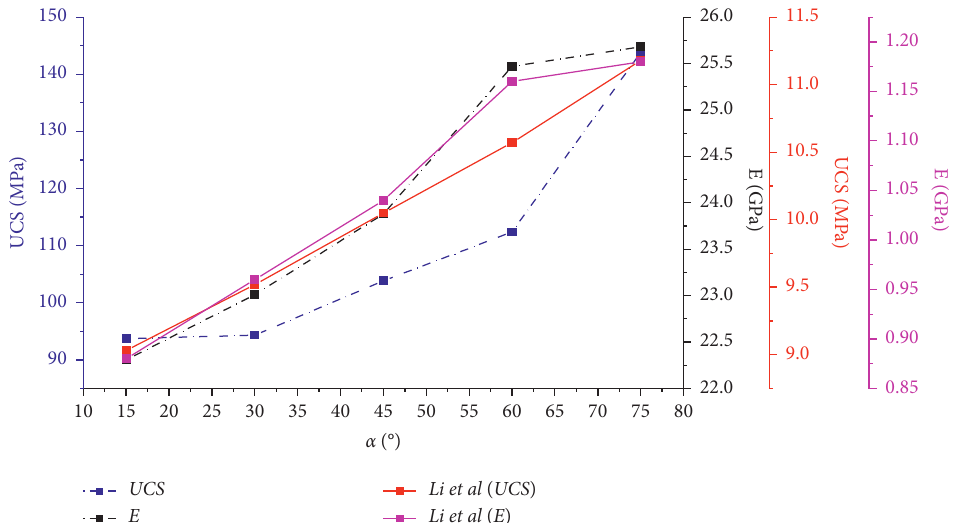
Figure 6: Cracked concrete peak strength and elastic modulus at various inclination